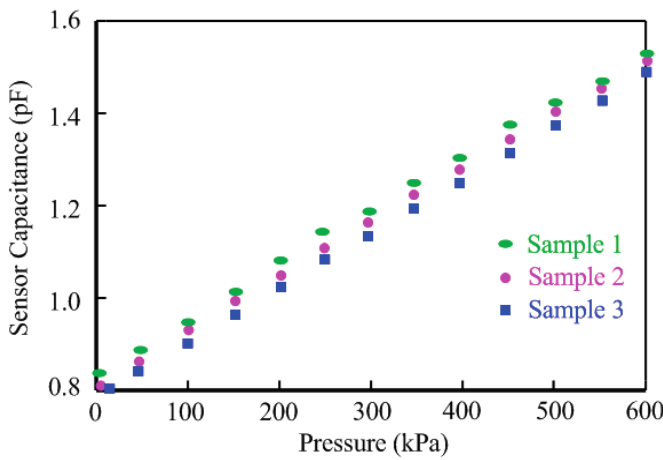
Figure 8. Sensor capacitance vs. pressure of three sample chips.